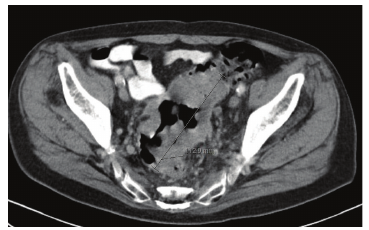
Figure 2: CT scan revealing 11.3cm sigmoid